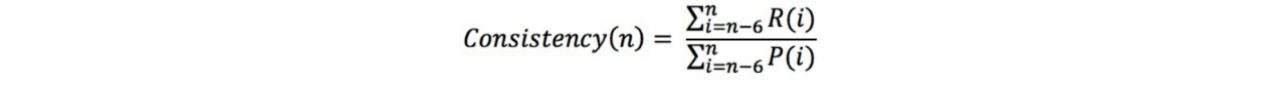
Figure 3. Consistency